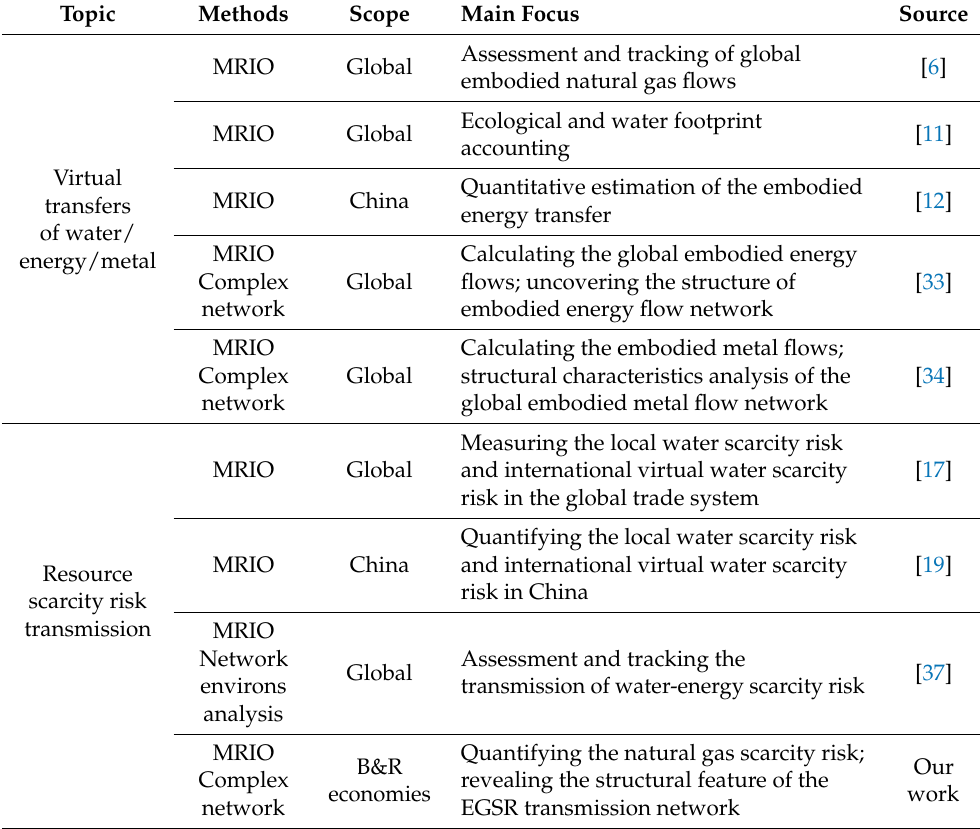
Table 1. Research on virtual transfers in recent